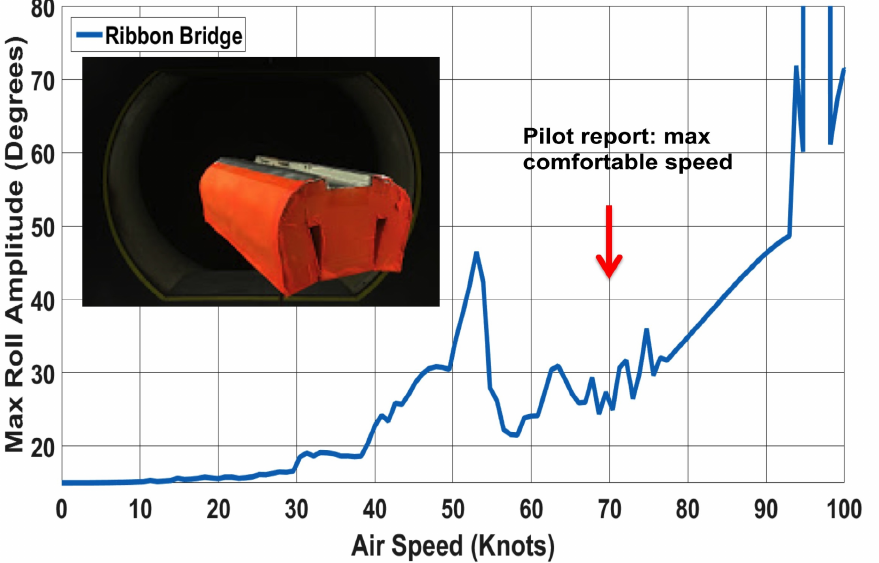
Figure 6. Maximum roll amplitude versus flight speed for a ribbon bridge model, predicted by dynamic simulation with model-scale wind-tunnel aerodynamic data, compared to flight test points. From [100] by permission of authors.